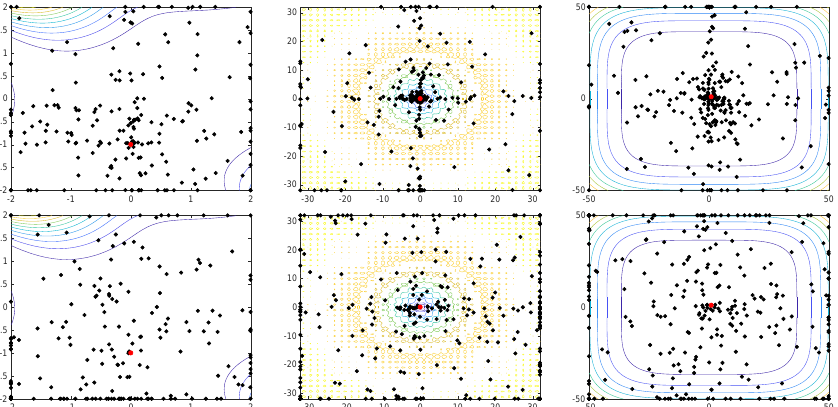
Figure 4. Search maps of search agents when solving functions f 21 , f 24 , and f 25 ; by the ESCA algorithm ( first row ); and the SCA algorithm ( second row ).